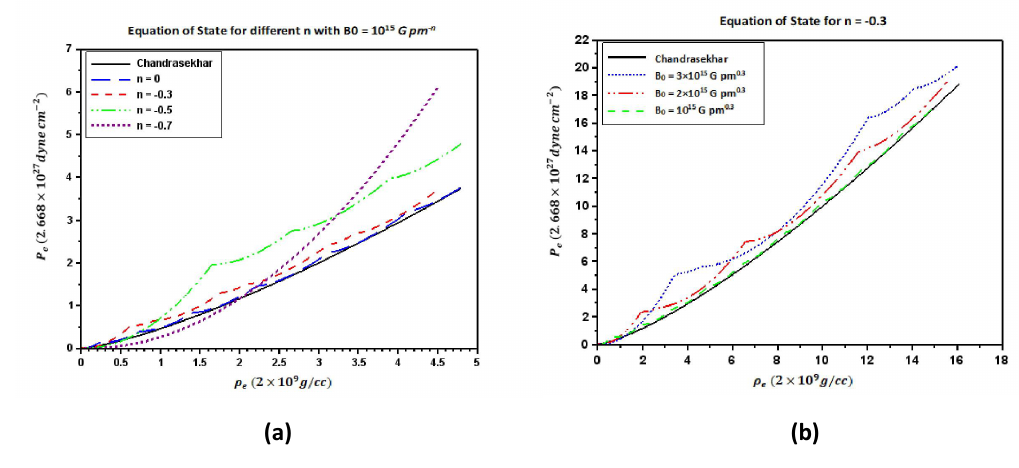
= 17 (long-dashed blue line), Figure 8: (a) Equation of state for n = 0 with ε Fmax = 17 (dashed red line), n = − 0.5 with ε = 18 (dot-dashed n = − 0.3 with ε Fmax Fmax = 15 (dotted violate line), for B = 10 15 G green line) and n = − 0.7 with ε Fmax 0 = 17 (solid black line), (b) pm − n , along with Chandrasekhar’s result with ε Fmax = 10 15 G pm − n (dashed green line), 2 × 10 15 G pm − n (dot- Equation of state for B 0 dashed red line) and 3 × 10 15 G pm − n (dotted blue line) along with Chandrasekhar’s = 25, when pressure is in units of result (solid black line) for n = − 0.3 with ε Fmax 2.668 × 10 27 erg cm − 3 and mass density in units of 2 × 10 9 gm cm − 3